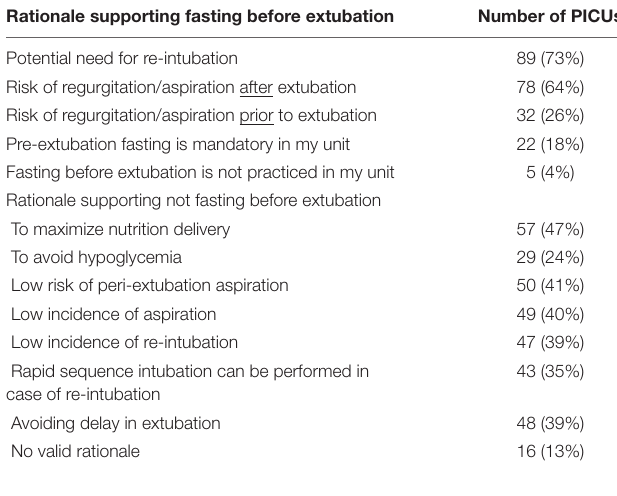
TABLE 4 | Proposed rationales for fasting and not fasting